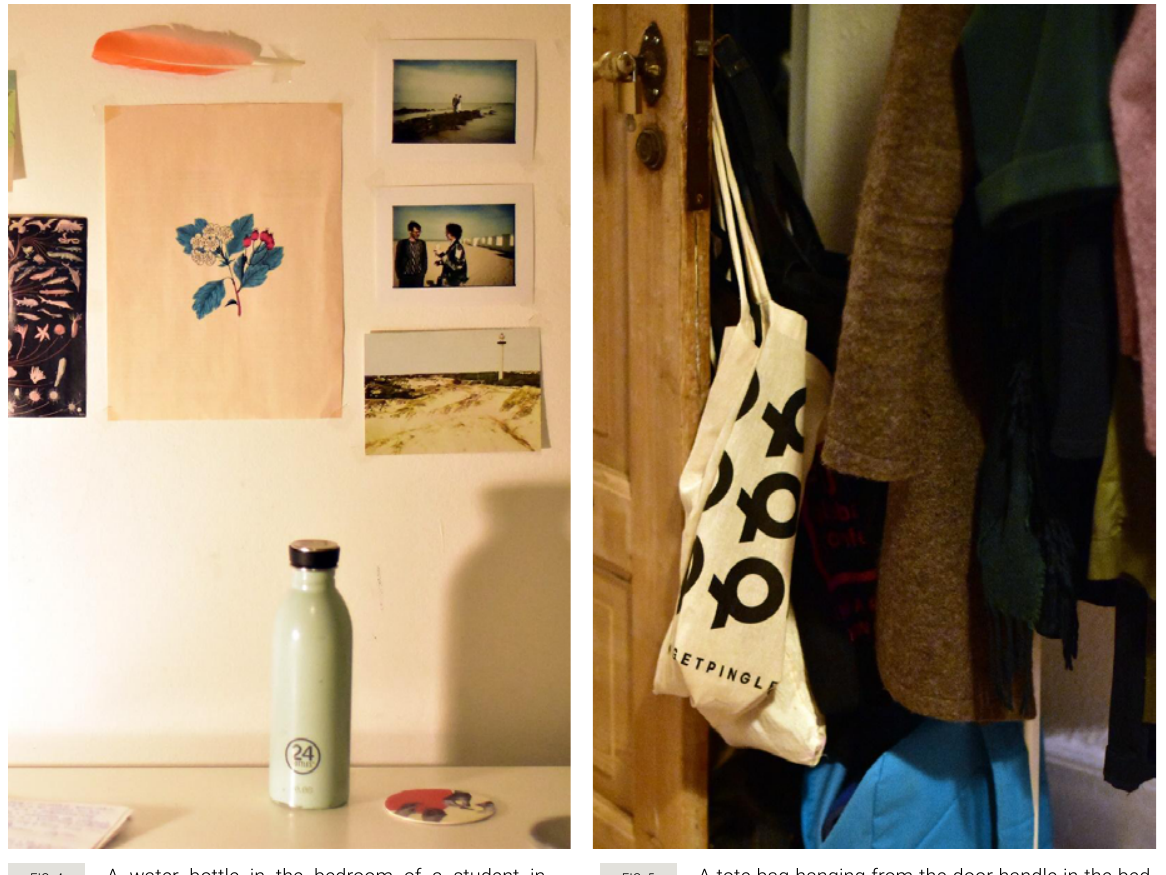
FIG. 4 FIG. 5 A water bottle in the bedroom of a student in Copenhagen, November 2018. Photograph by author.